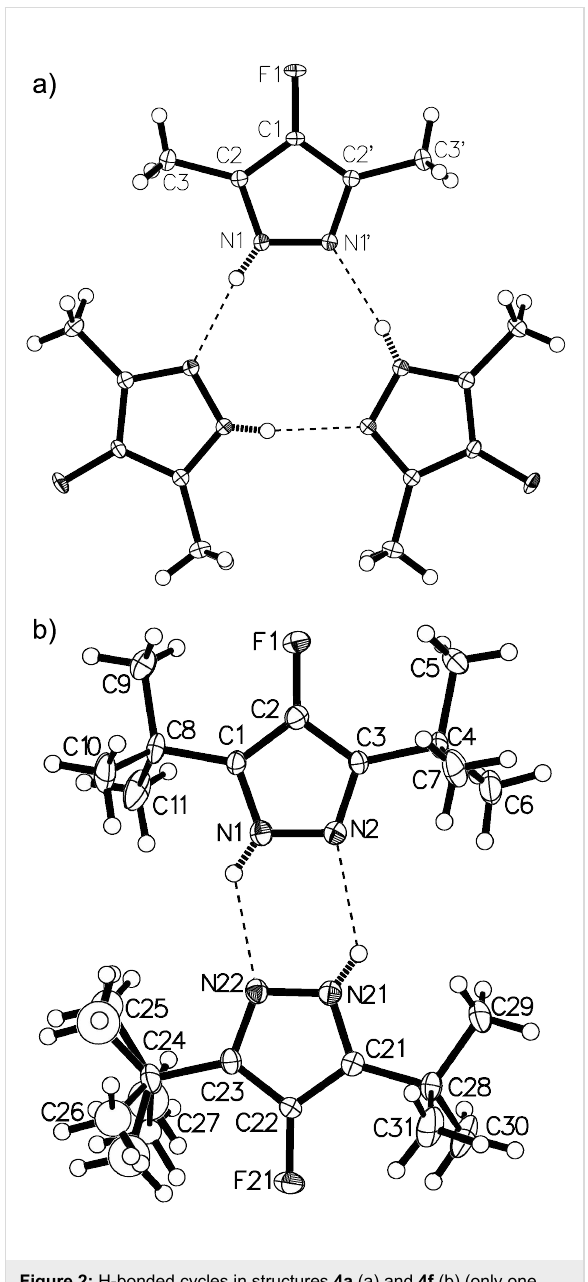
Figure 2: H-bonded cycles in structures 4a (a) and 4f (b) (only one disordered pyrazole hydrogen atom is shown in each